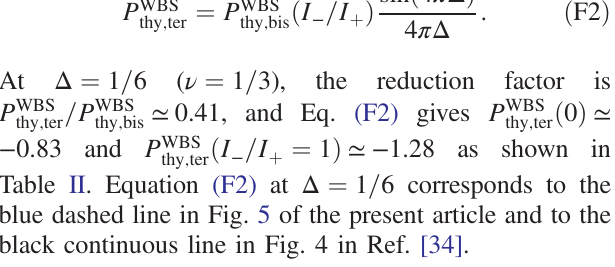
Table II. Equation (F2) at Δ ¼ 1 = 6 corresponds to the blue dashed line in Fig. 5 of the present article and to the black continuous line in Fig. 4 in Ref.